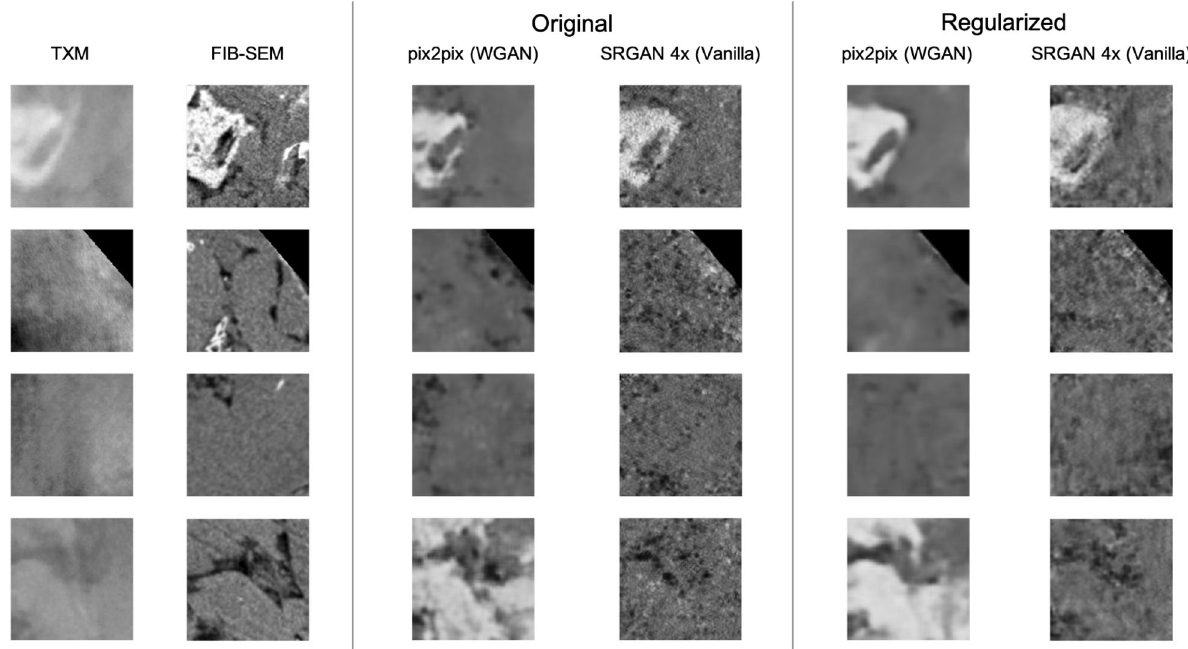
Figure 3. 2D-to-2D image translation results. Each row contains the input TXM image patch and ground truth FIB-SEM image patch, and translated image patches for the pix2pix (WGAN) and SRGAN 4x (Vanilla) models both with and without the continuity loss term. The Jacobian loss term causes the translation models to synthesize fewer details in the images. Specifically, we observe that fewer low-density regions are synthesized by the regularized models. Software: Powerpoint www. micro soft. com.